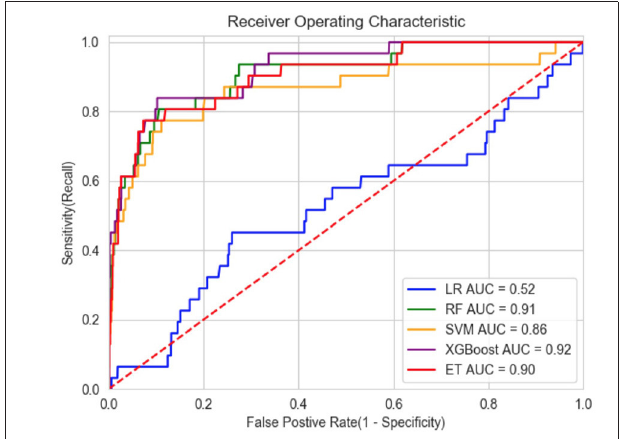
FIGURE 3 | ROC of models. LR, Logistic regression; RF, Random Forest; SVM, Support Vector Machines; ET,